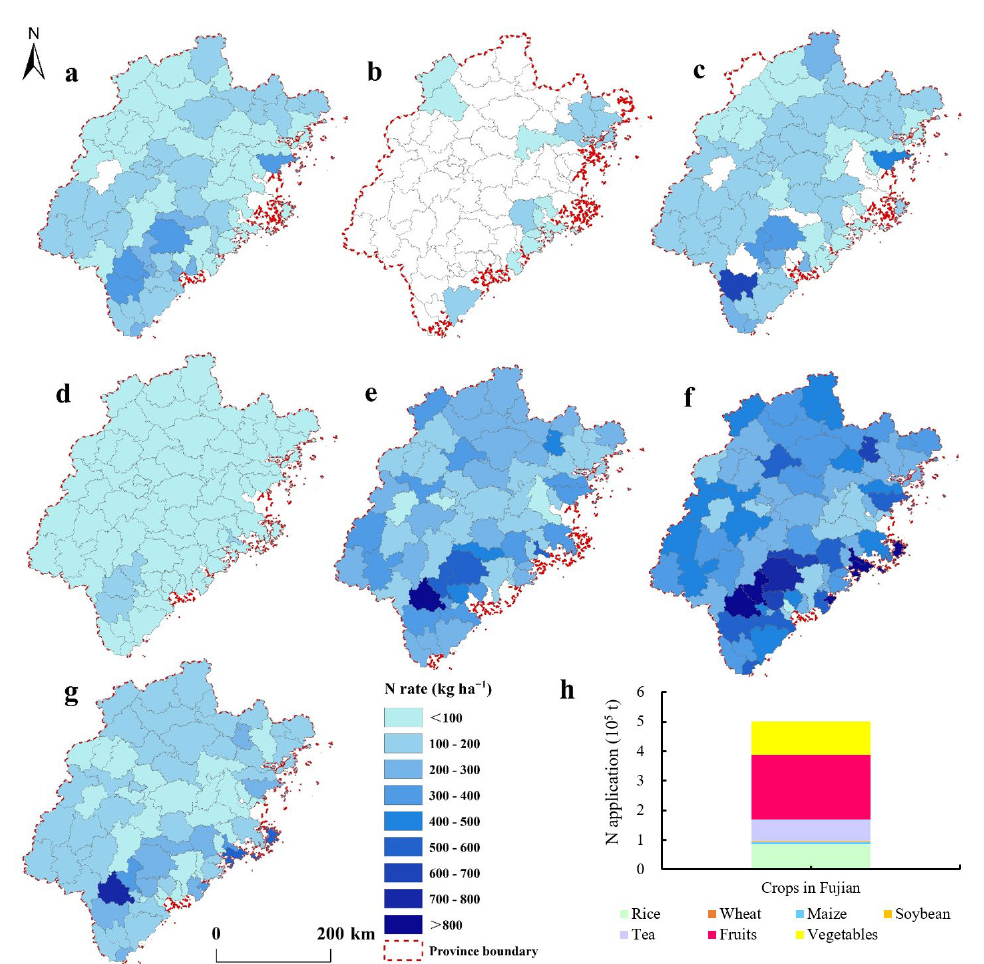
Figure 2. The spatial patterns of N rate of various crops including rice ( a ), wheat ( b ), maize ( c ), soybeans ( d ), tea ( e ), fruits ( f ), and vegetables ( g ) at the county level in Fujian Province, as well as the N application amounts on various crops in Fujian Province ( h ).